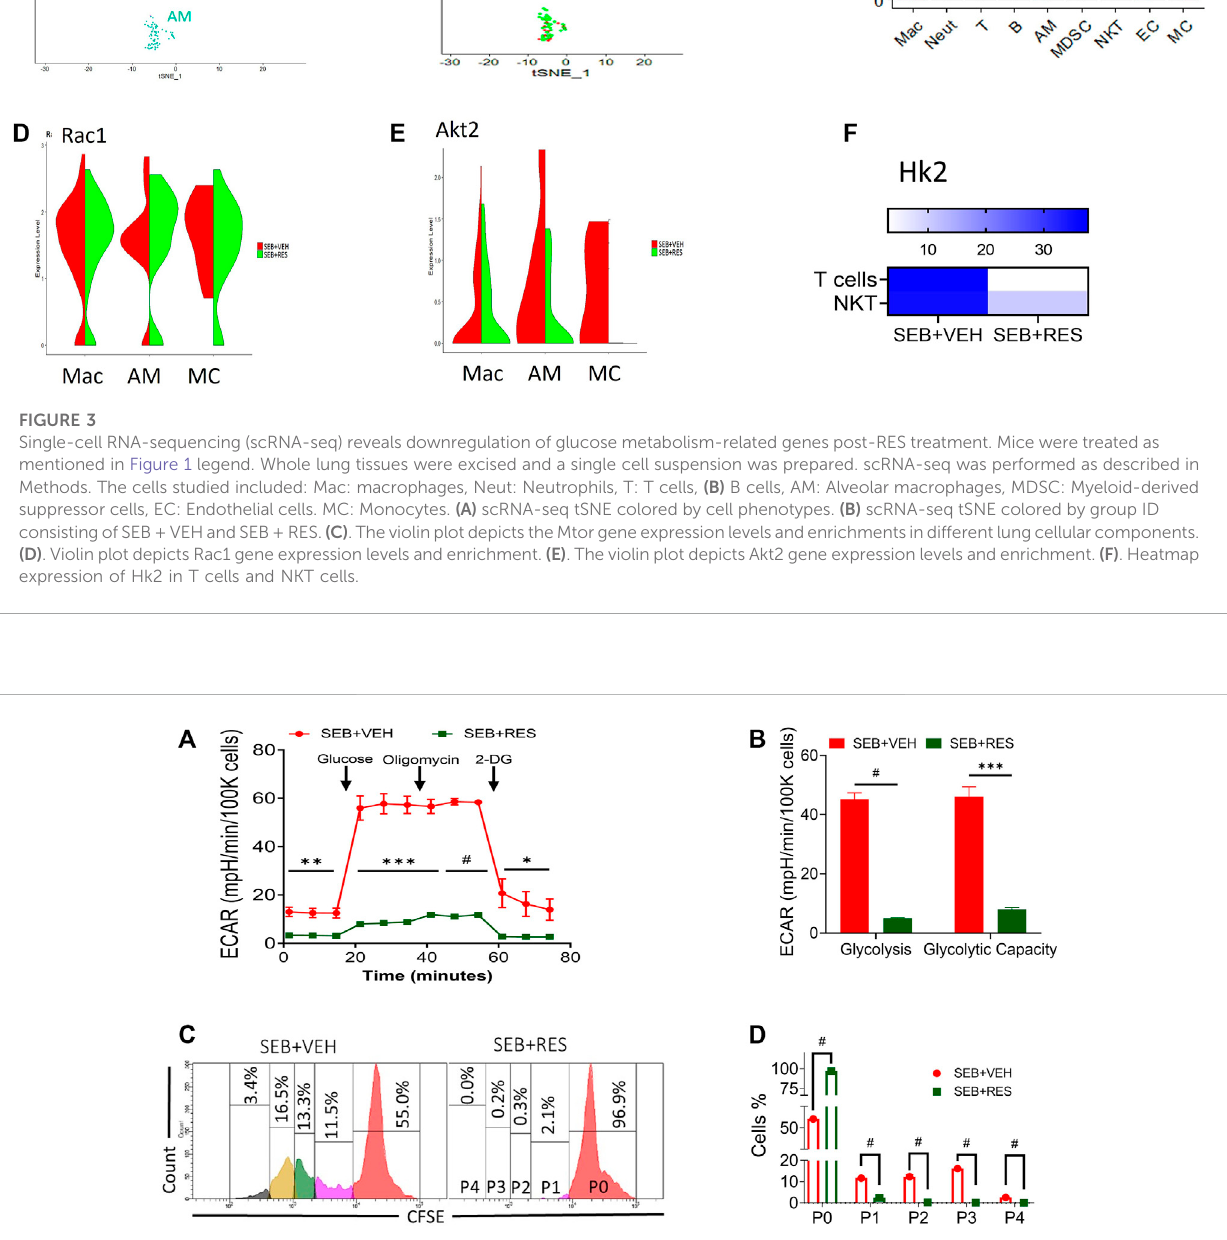
Effect ofRES on glycolysis and proliferative capacity of SEB-activatedT cells. Mice were treated as mentioned in Figure 1 legend. Whole lung tissues were excised and the single cell suspension was prepared for real-time metabolism analysis. (A) . Real-time analysis of T cell glycolysis measured by Seahorsesystembasedonthecalculationofextracellularacidi fi cationrate(ECAR)changes. (B) .GlycolysisstatisticalkineticsofTcellscalculatedbyusing Report Generator software. (C) . CFSE staining follows T-cell division in vitro . Naïve splenocytes were incubated with CFSE dye at a concentration of 10 μ M for 20 min at room temperature before being washed and treated with RES or VEH and then activated with 1 μ g/ml SEB for 48 h. P, parent cells, 0 – 4 sequence of cell division. (D) . Statistical analysis of T cell divisions depicted as P0-P4. Compared values represent mean ± standard error of means (M ± SE). One-way ANOVA test with multiple Tukey ’ s correction was applied to compare more than two groups. T-test was applied with Holm-Sidak correction method to compare two groups. p < 0.05 considered as signi fi cant threshold. Signi fi cant differences were depicted as * p < 0.05, ** p < 0.01, *** p < 0.001, # p < 0.0001.